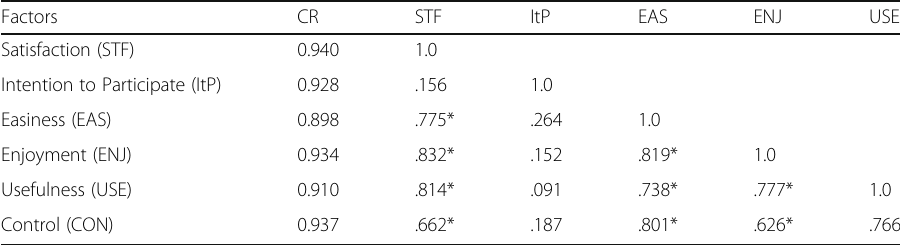
Table 4 Summary of measurement